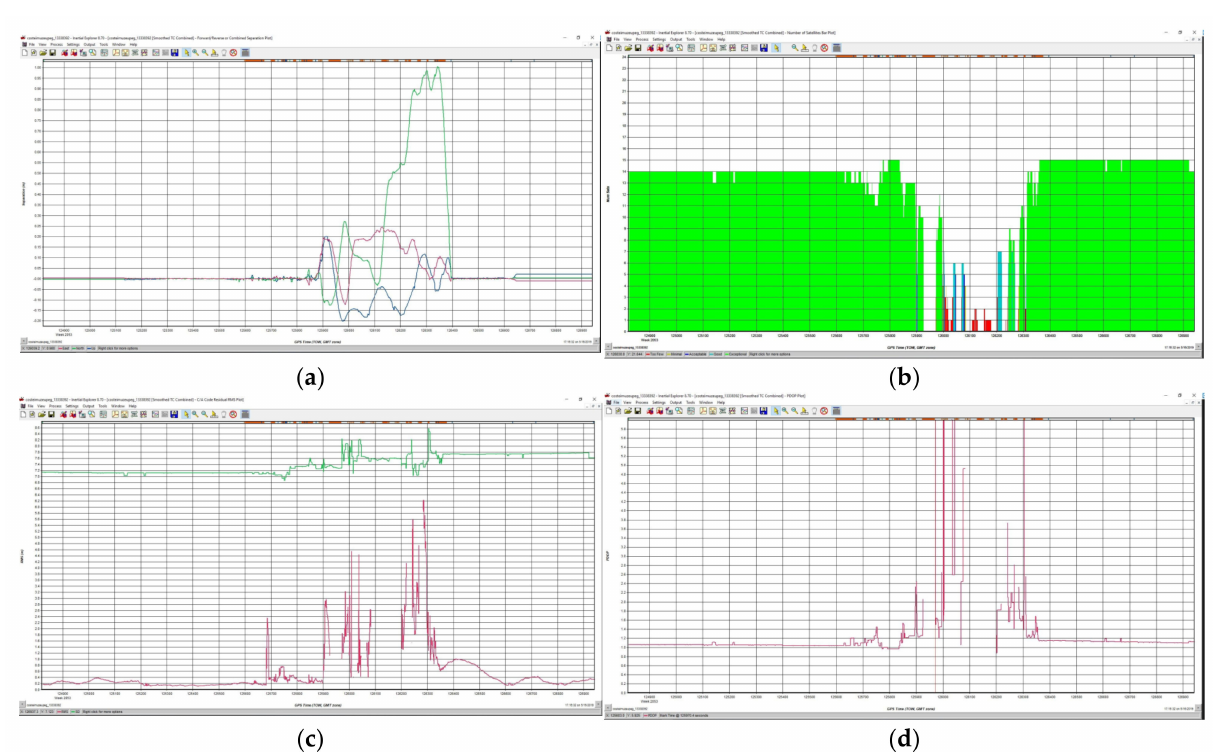
Figure 26. 3D scanning of the HN Cos teiu—Museum lens on: 13.05.2019: ( a ) View of scan accuracy , (Combined separation); ( b ) The number of visible satellites at the time of the scan; ( c ) RMS values; ( d ) PDOP